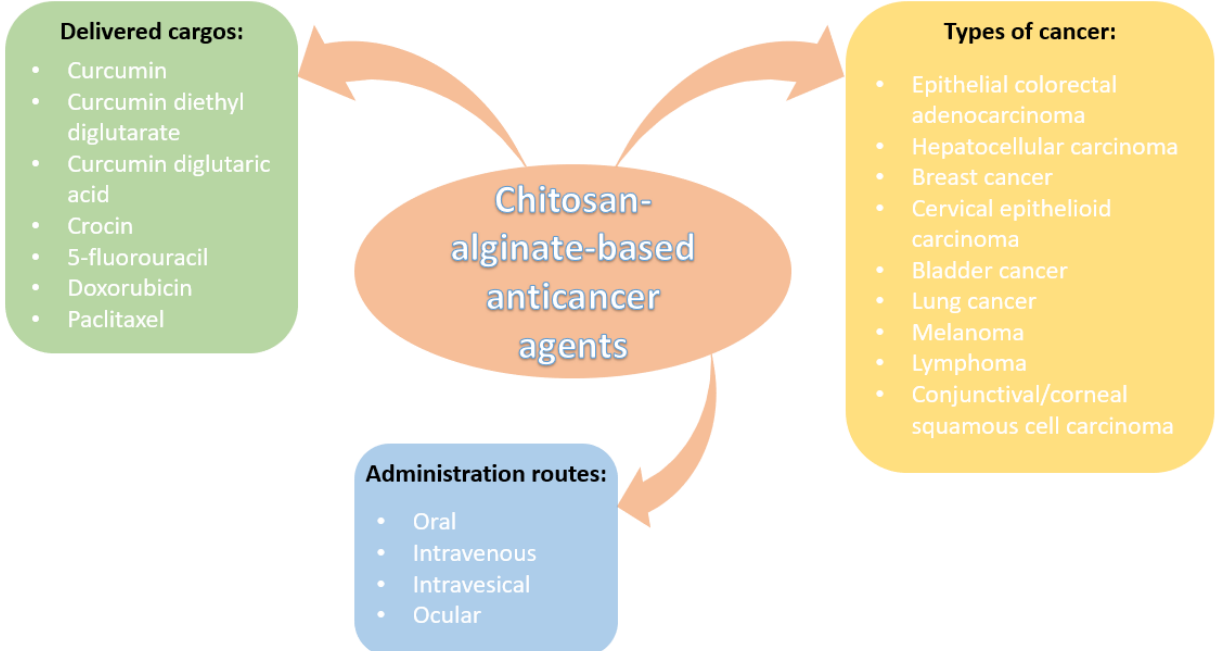
Figure 6. Overview of chitosan-alginate-based anticancer nanoformulations.